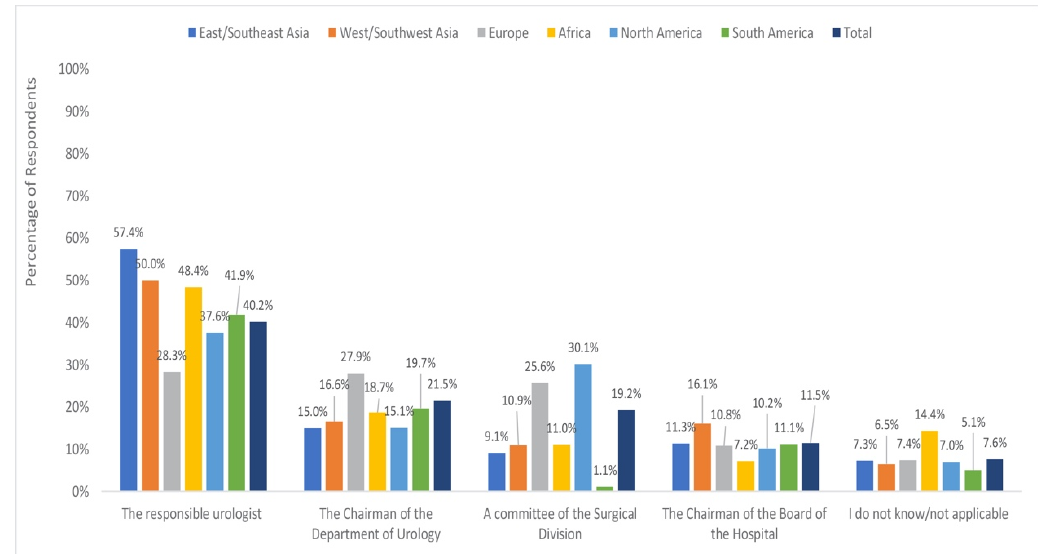
Figure 4. Responsibility for deciding which operations take place by region .